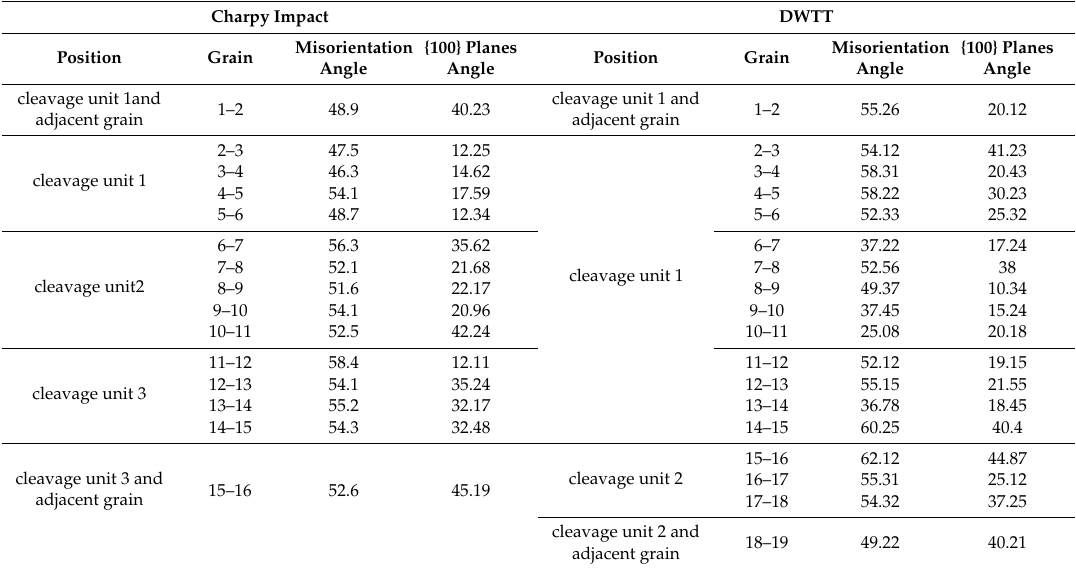
Table 3. Statistics of the crystal orientation relationship between Charpy impact and DWTT samples: Charpy impact corresponding to Figure 11a,b DWTT corresponding to Figure 11b.